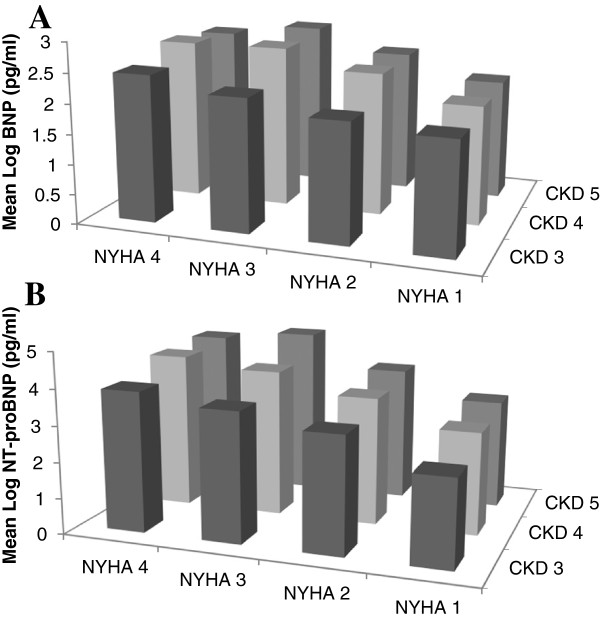
Impact of chronic kidney disease and New York Heart Association Classification on natriuretic peptides. A. Log BNP according to CKD stages and NYHA classification. B. Log NT-proBNP according to CKD stages and NYHA classification.